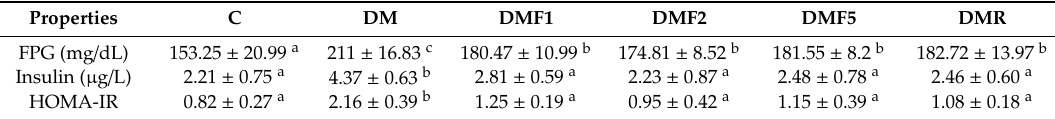
Figure 2. Effects of fucoxanthin on plasma glucose after treatment for four weeks. ( A ) Oral glucose tolerance test (OGTT) and ( B ) area under the curve (AUC) of plasma glucose. Data are shown as the mean ± S.D. ( n = 5). The values with different letters (a–c) represent significant differences ( p < 0.05) as analyzed by Duncan’s multiple range test. C, control; DM, diabetes; DMF, diabetes treated with fucoxanthin; DMR, diabetes treated with rosiglitazone. Table 1. Effects of fucoxanthin on fasting plasma glucose (FPG), insulin level, and HOMA-IR after treatment for four weeks.